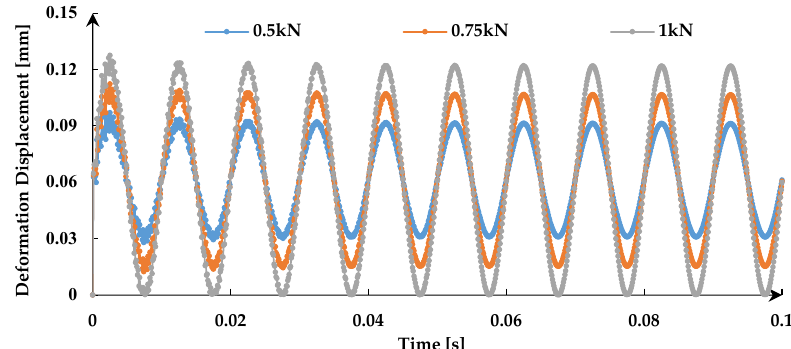
Figure 11. Numerical results showing deformation displacement versus time relationships of the rock for cylindrical indenter under static-dynamic loads with different amplitudes of dynamic load.